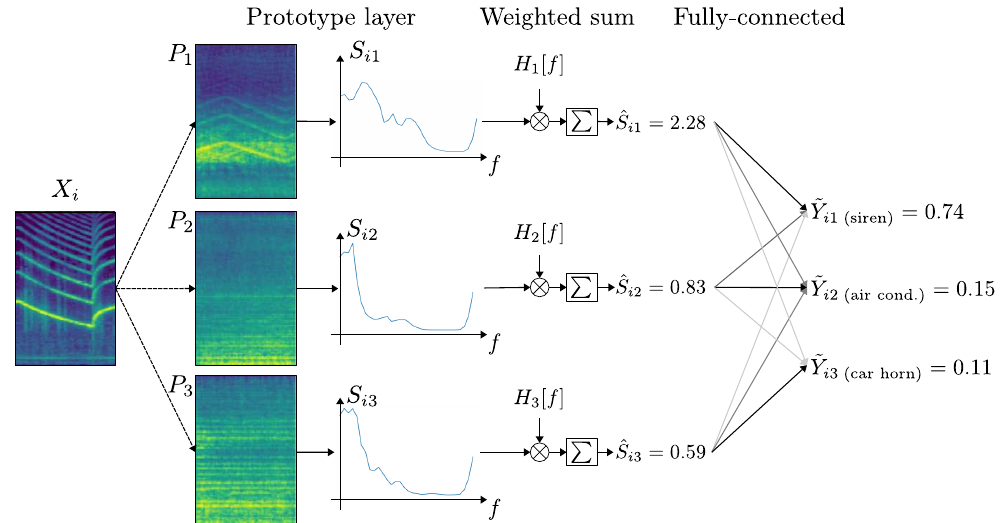
Figure 3. Illustration of how the model makes its predictions. This is an example with three classes: siren , air conditioner , and car horn . The input X i is compared to three prototypes (one per each class) to get the frequency-dependent similarity S ij r f s . This similarity is integrated in the frequency dimension p S ij . The final step in the reasoning process is to calculate the using the weighted sum layer to obtain r Y ik ) by projecting the similarity using a fully-connected layer. Note that gray scale in the prediction ( fully-connected arrows denote the strength of the